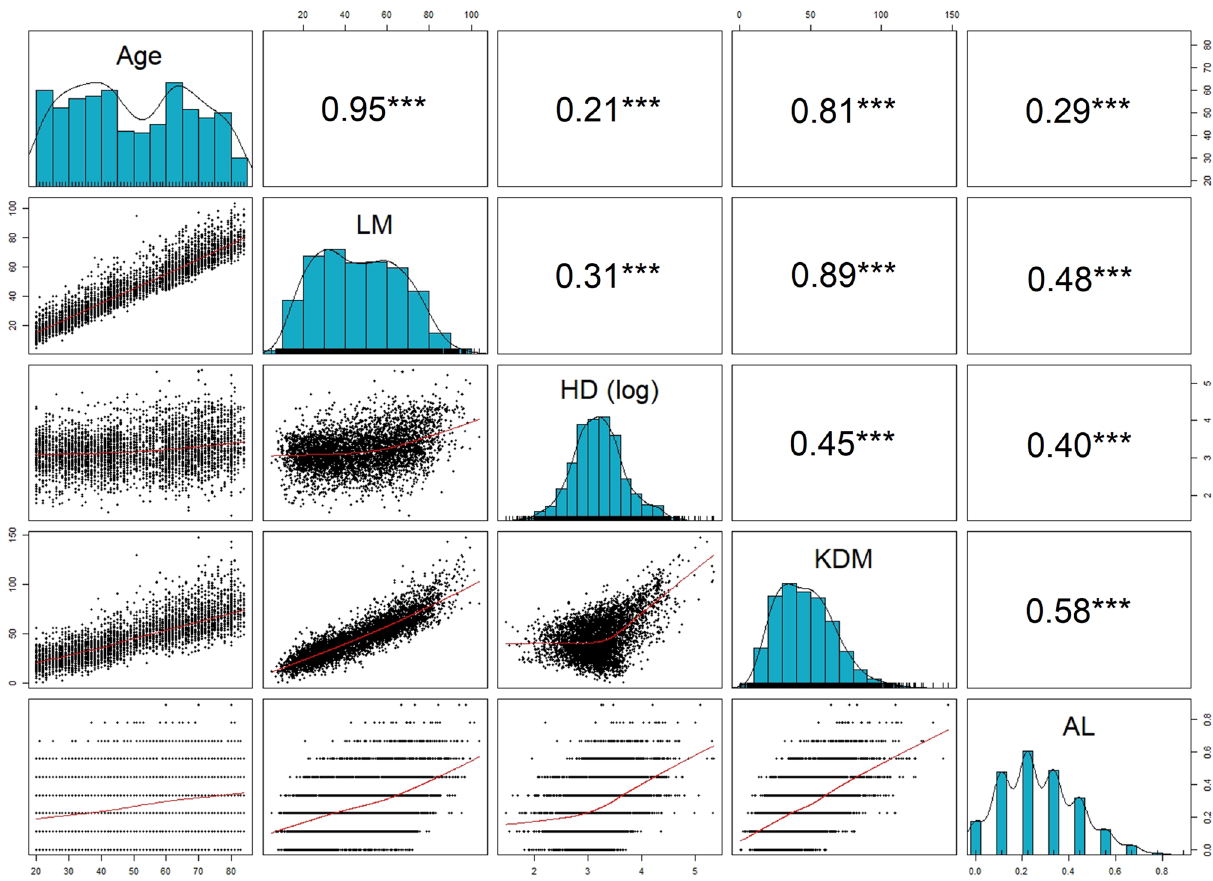
Figure 3. Associations between measures of chronological and biological age employed in the present study, National Health and Nutrition Examination Survey 1999–2010 ( n = 4418). Numbers represent Pearson correlation coefficients. Note: *** p < 0.001; LM, Levine Method; HD, homeostatic dysregulation; KDM, Klemera-Doubal Method; AL, allostatic